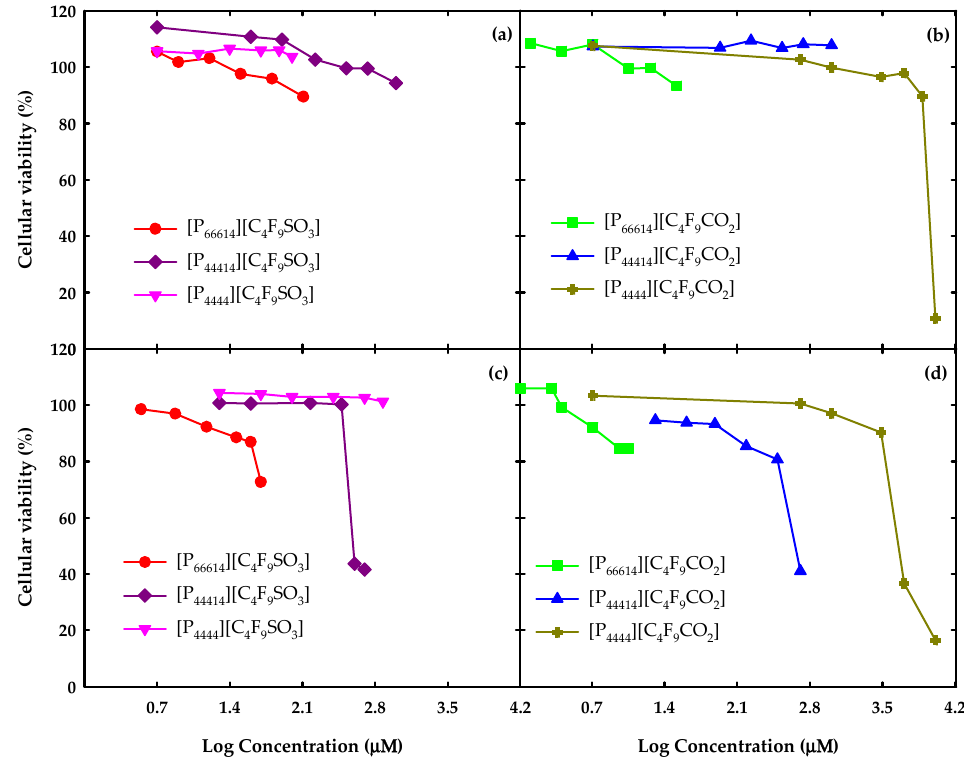
Figure 7. Cellular viability determined in this work for phosphonium synthesized FILs with: ( a ) the sulfonate anion in Caco-2 cell line; ( b ) the carboxylate anion in Caco-2 cell line; ( c ) the sulfonate anion in HepG2 cell line; and ( d ) the carboxylate anion in HepG2 cell line. Table 4. Half-maximal effective dose (EC 50 ) for the Caco-2 and HepG2 cell lines after 24 h of FILs exposure.